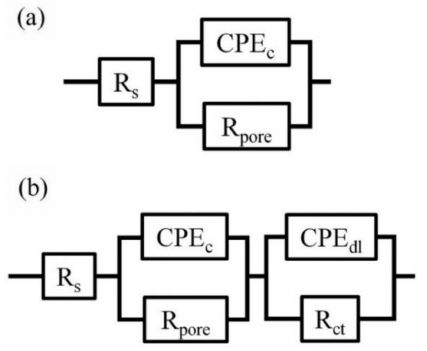
Figure 3. Equivalent circuits with ( a ) one time constant and ( b ) use of two time constants for fitting electrochemical impedance spectroscopy (EIS) data of coating samples.